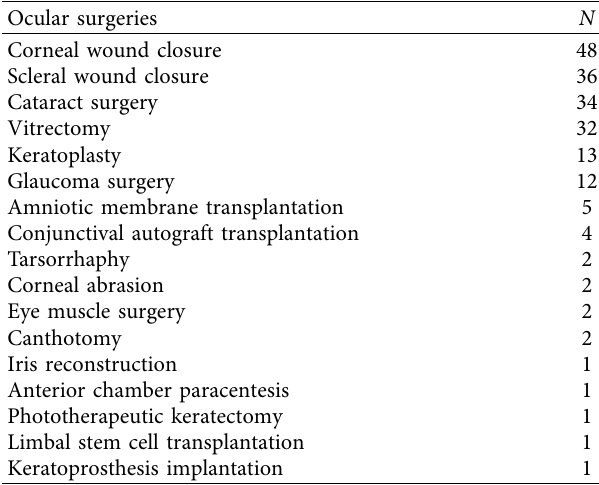
Table 3: Ocular surgeries between ocular trauma and secondary enucleation/evisceration.